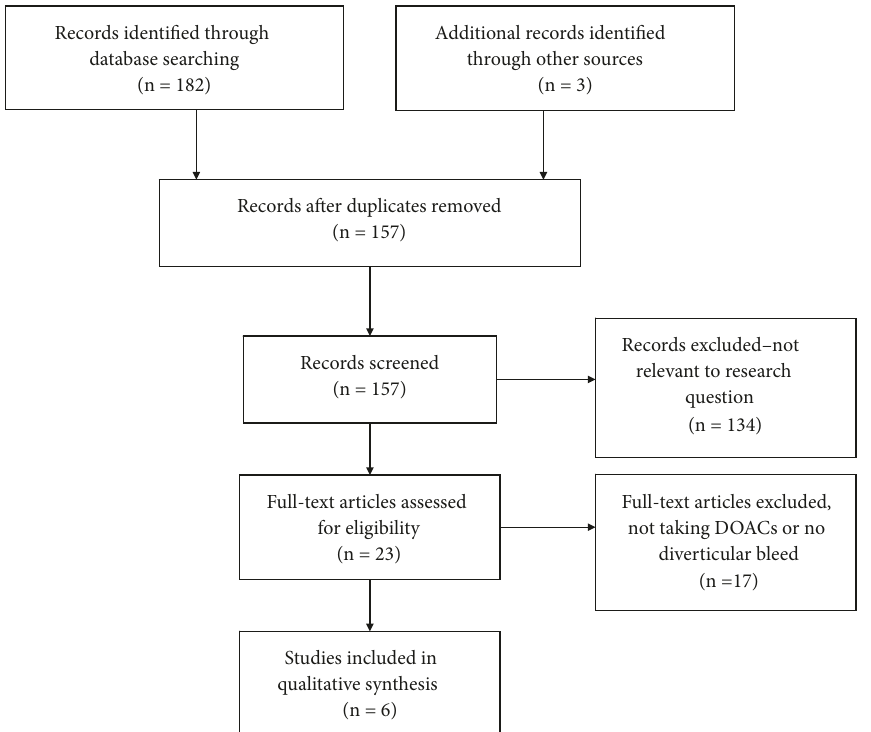
Figure 1: Article selection for inclusion in the systematic